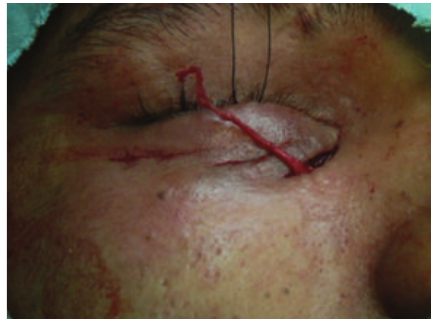
Figure 6: Postoperatively the inferior fornix was deep and the lower lid laxity was